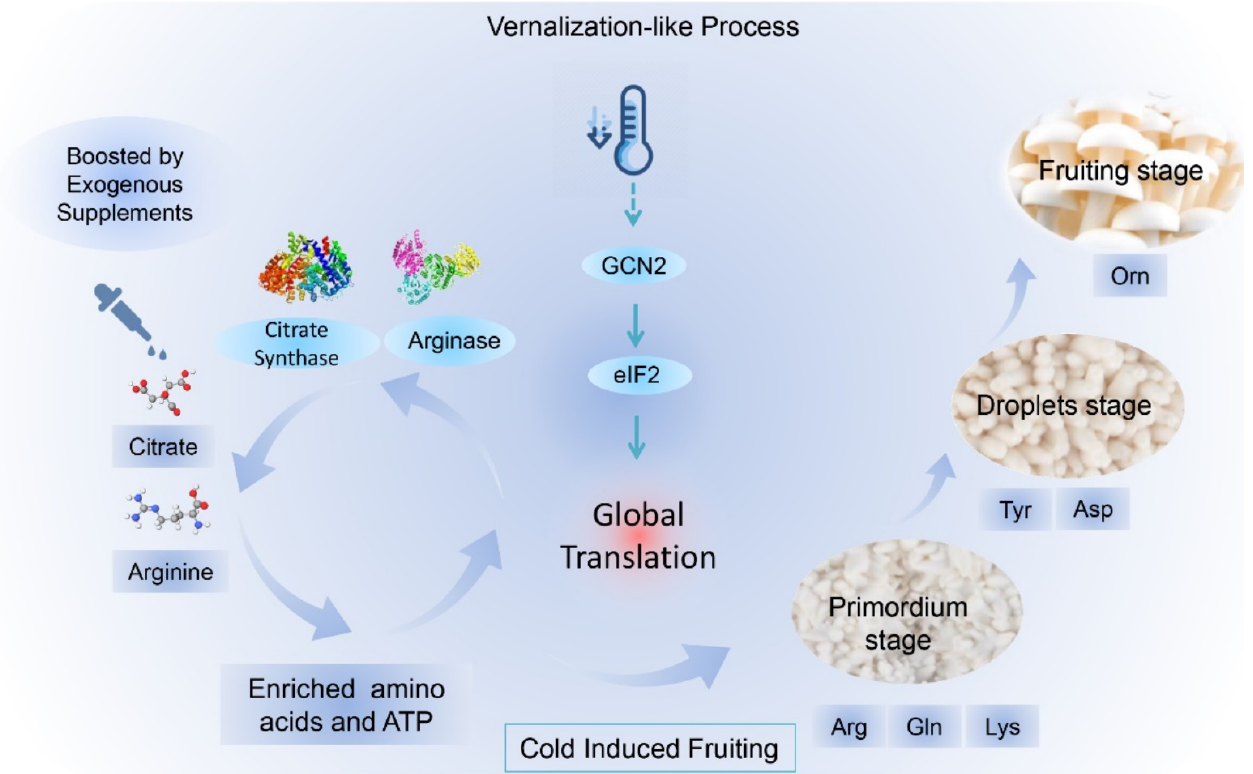
Figure 7. A potential model of GCN2-mediated translation regulation for low-temperature fruiting after long postripening (LFLP) in H. marmoreus . Low temperature stimulated the GCN2-mediated eIF2 translation pathway with the enriched amino acids and ATP in LFLP, which are essential for promoting global translation. The synergistically increased citrate and Arg may promote amino acid synthesis and ATP production for global translation in H. marmoreus .